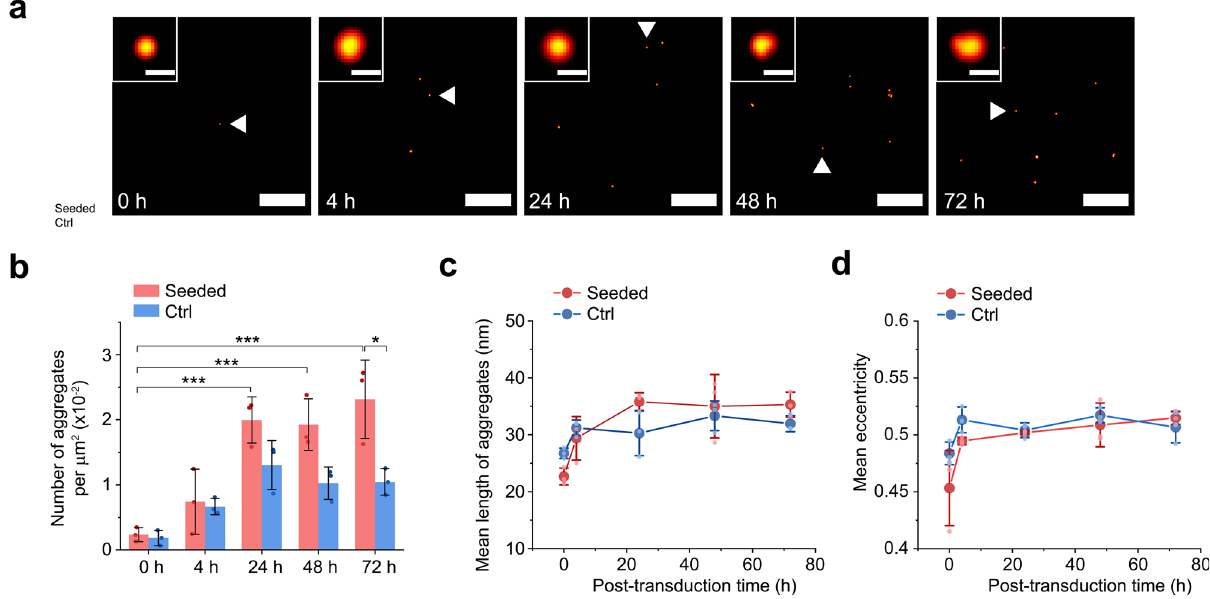
Fig. 3 Seeded cells secrete small aggregates. Culture medium was collected at de fi ned time points after seeding and imaged with AD-PAINT. a Super- resolution images of extracellular aggregates. Secreted aggregates accumulate over time following seeding ( b ), while their length ( c ) and eccentricity ( d ) increase slightly. Statistical difference was determined by two-way ANOVA with Tukey ’ s multiple comparison test. * p < 0.05, ** p < 0.01, *** p < 0.001. Mean± SD from three biological replicates. Scale bars in a : 500 nm (main panels) and 25 nm